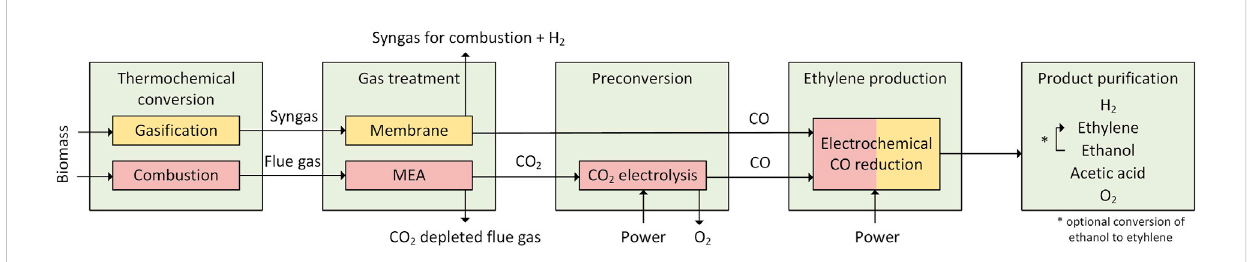
FIGURE 1 Sketch of the two process routes starting from biomass residues with either biomass gasi fi cation (orange) or biomass combustion